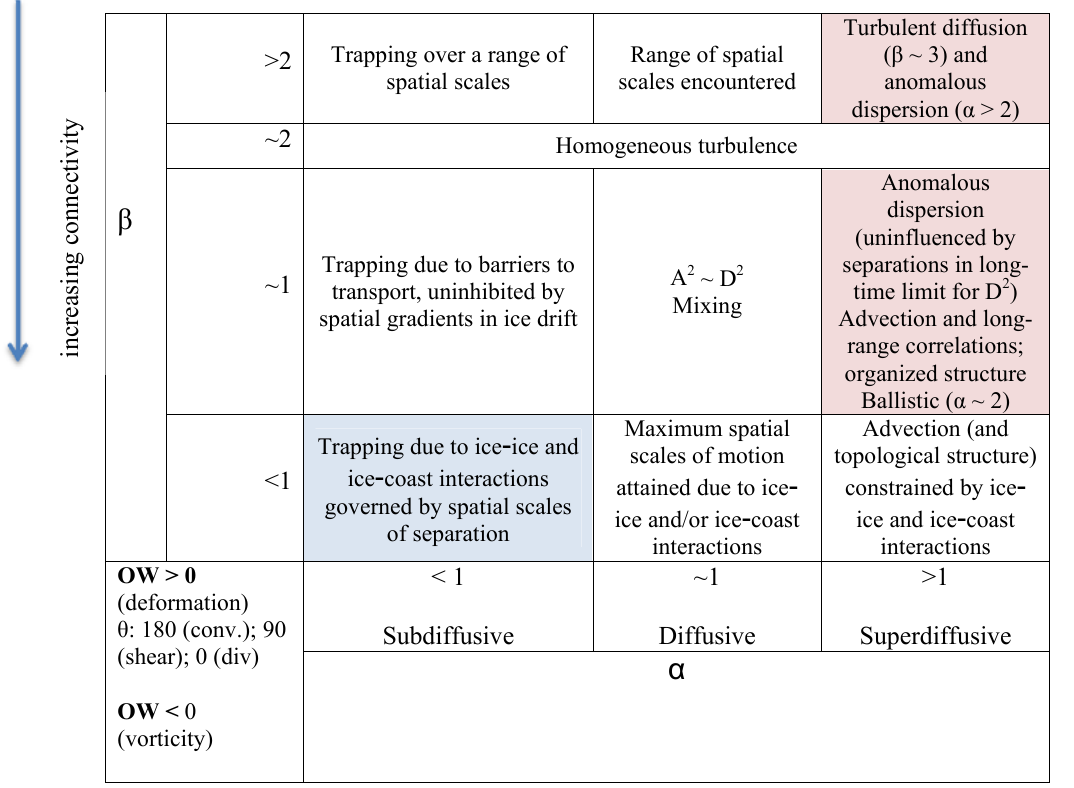
Table 3. Sea ice drift and deformation: single-particle ( α ) and two-particle ( β ) scaling laws with three-particle Okubo–Weiss (OW) criterion cross